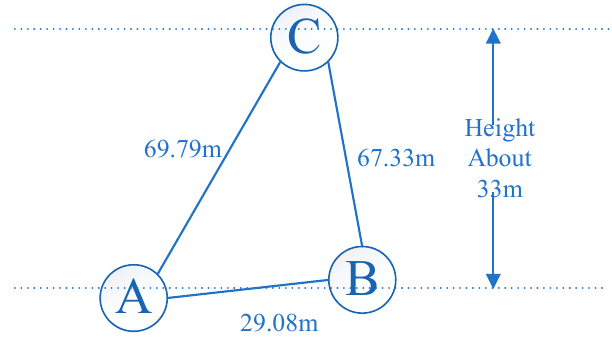
Figure 5. Diagram of the relative positions of the three stations.